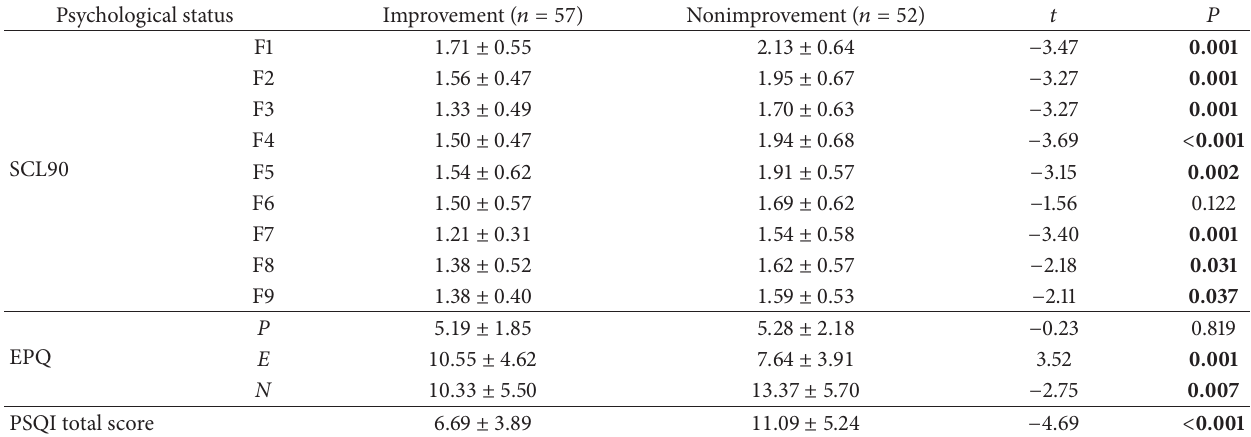
Table 2: The comparison of psychological status in different prognosis groups